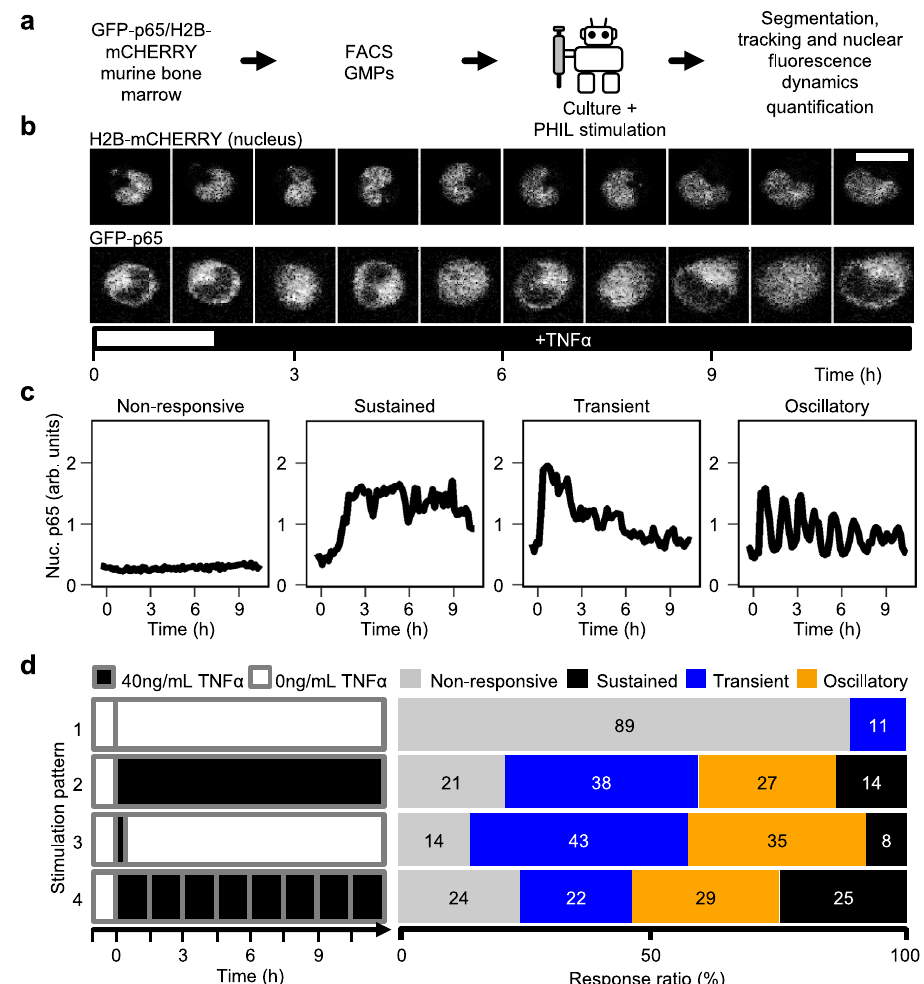
Fig. 7 PHIL automates parallel cytokine stimulation in sensitive cell cultures without media cross contamination or disrupting time-lapse imaging. a Freshly sorted GFP-p65/H2B-mCHERRY GMPs were imaged during PHIL culture and stimulation before cell segmentation and tracking (scale bar: 10 μ